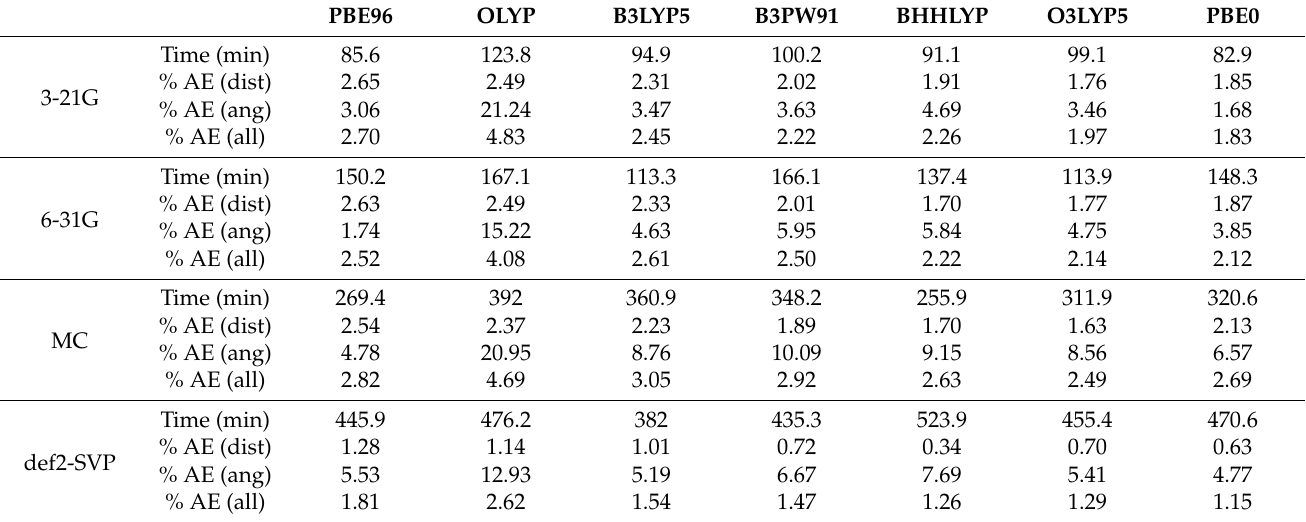
Table 3. Computing time and percent average error (AE%) at different functionals and basis